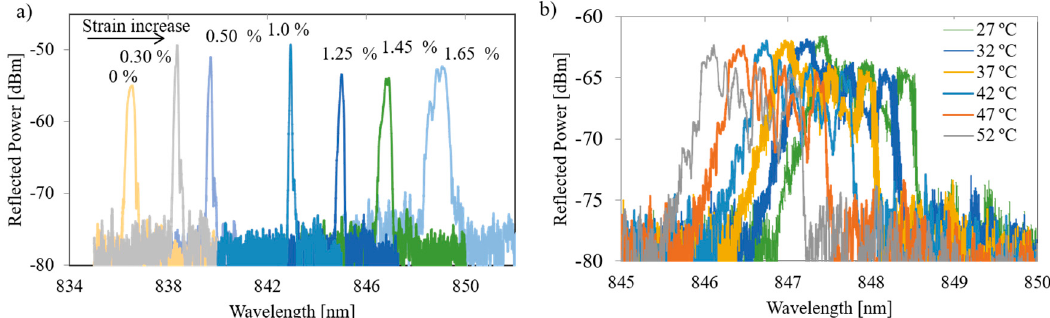
Figure 8. The reflected spectral power of chirped POFBGs ( a ) under different strain and ( b ) under different temperatures; image adapted from [109].